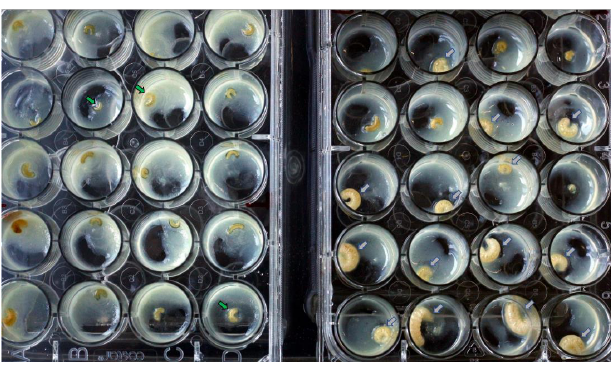
Figure 2. Observable differences between inoculated and control Apis cerana larvae in the second oral inoculation. The plate on the left shows the inoculated larvae; the plate on the right is the control group. Arrows indicate living larvae at 3 dpi. Of the inoculated larvae, 37.5% were dead at 3 dpi and the inoculated living larvae were smaller in size than the larvae in the control group The size difference shown in this figure is not described as an SBV symptom, which can be difficult to observe in a hive with different ages of larvae. Dead larvae showed SBV-like symptoms, color changes, and unshed cuticle; enlarged photographs are shown in Figure S2.